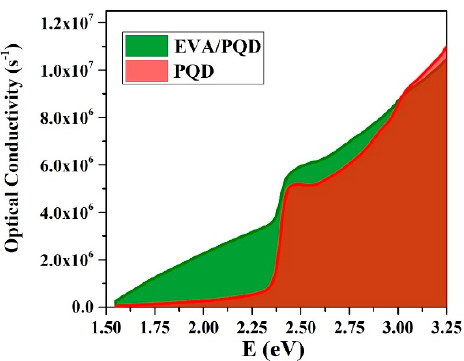
Figure 9. Optical conductivity of the pure PQD and the EVA-TPR/PQD